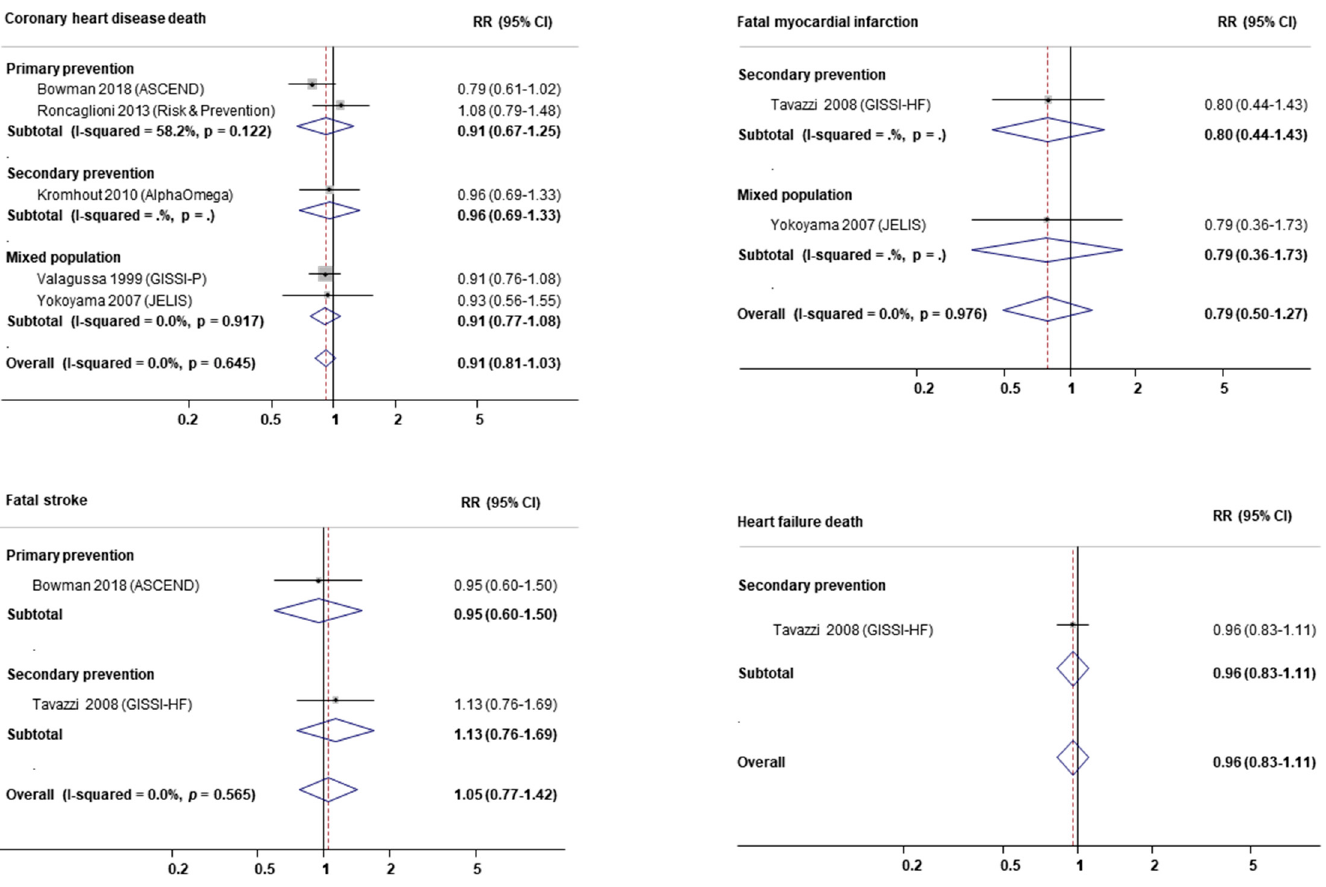
Figure A11. Subgroup meta-analysis for the effect of omega-3 supplementation on specific causes of cardiovascular disease death. Full black quadrilateral represents the point estimate of individual studies and blank with quadrilateral represents pooled estimates. RR, relative risk; CI, confidence interval. Pooled estimates for the overall study population and subgroups are highlighted with bold